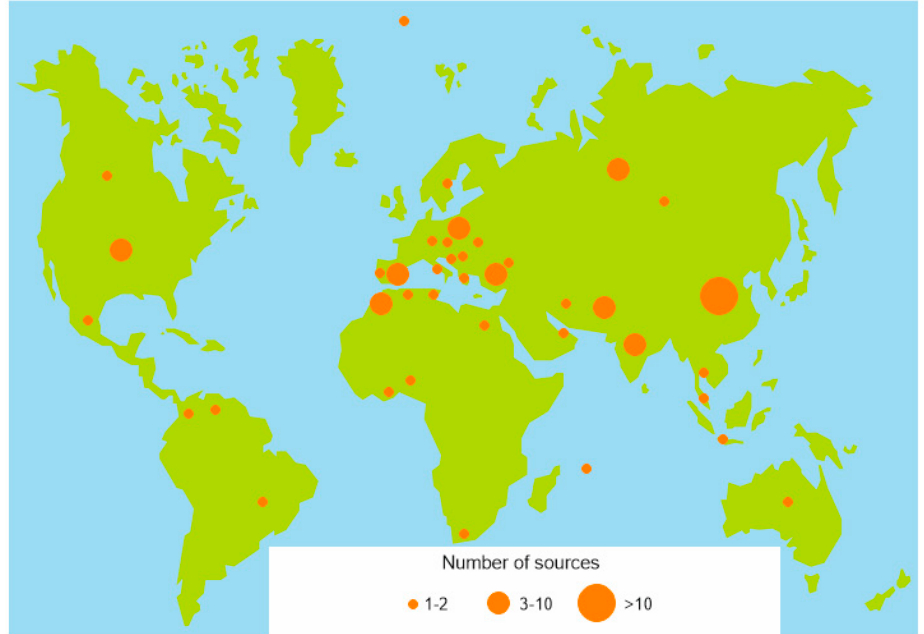
Figure 4. Geographical spread of the studies under review. See Table 1 for data.